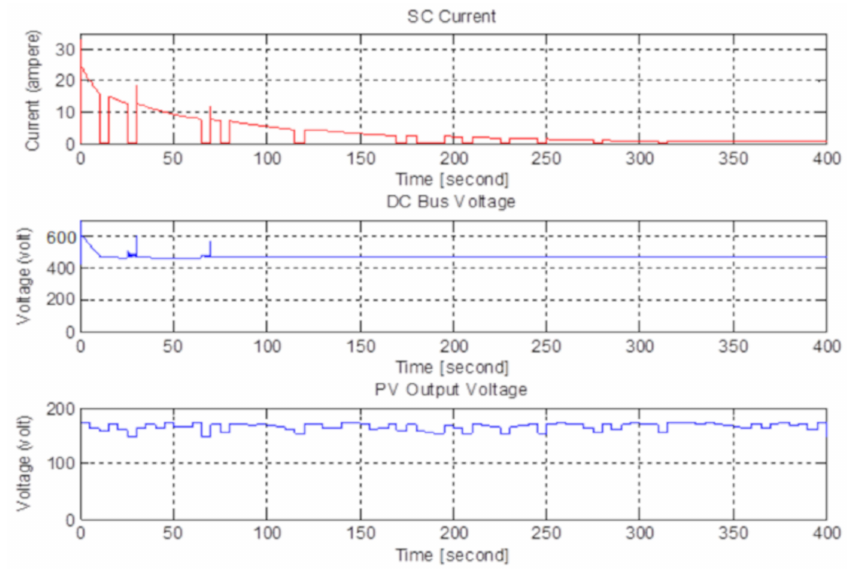
Figure 14. The simulation results of the supercapacitor stack current and voltage.